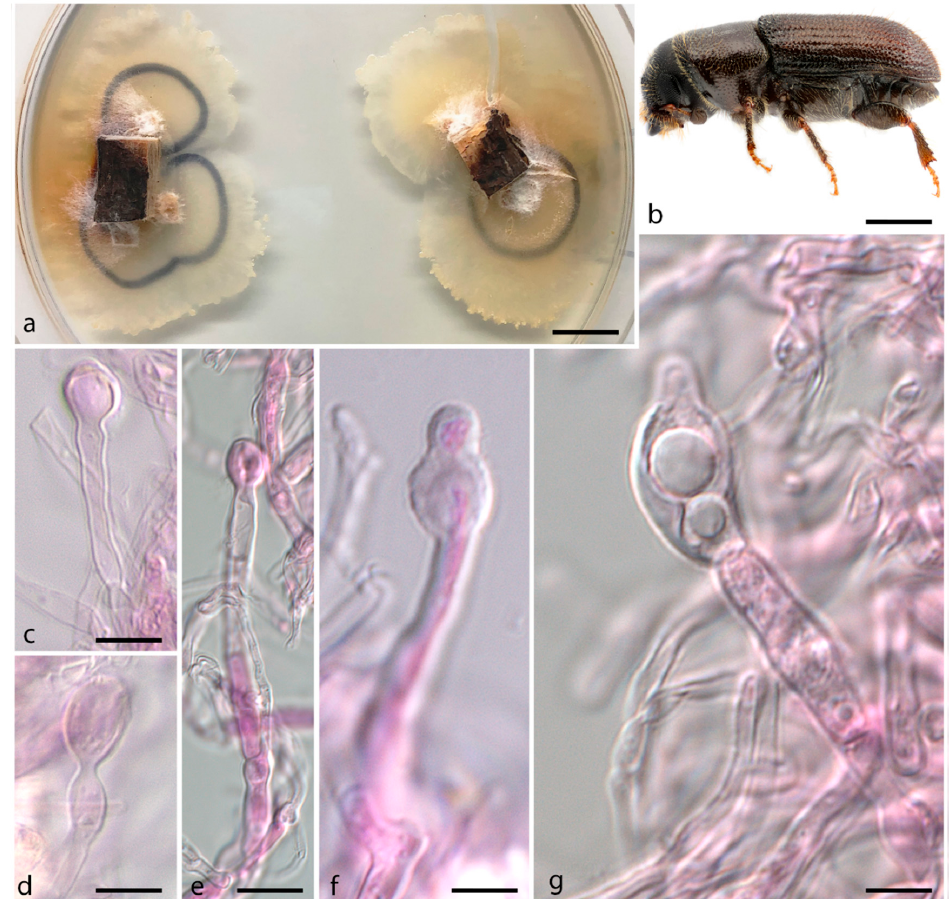
Figure 5. Entomocorticium belizense . ( a ) Culture aspect on PDA plate; ( b ) Dendroctonus frontalis ; ( c – f ) Early stages of aleurioconidia; ( g ) Fully developed aleurioconidia. Scale bars: ( a ) = 1 cm; ( b ) = 0.5 cm; ( c – g ) = 5 µm.